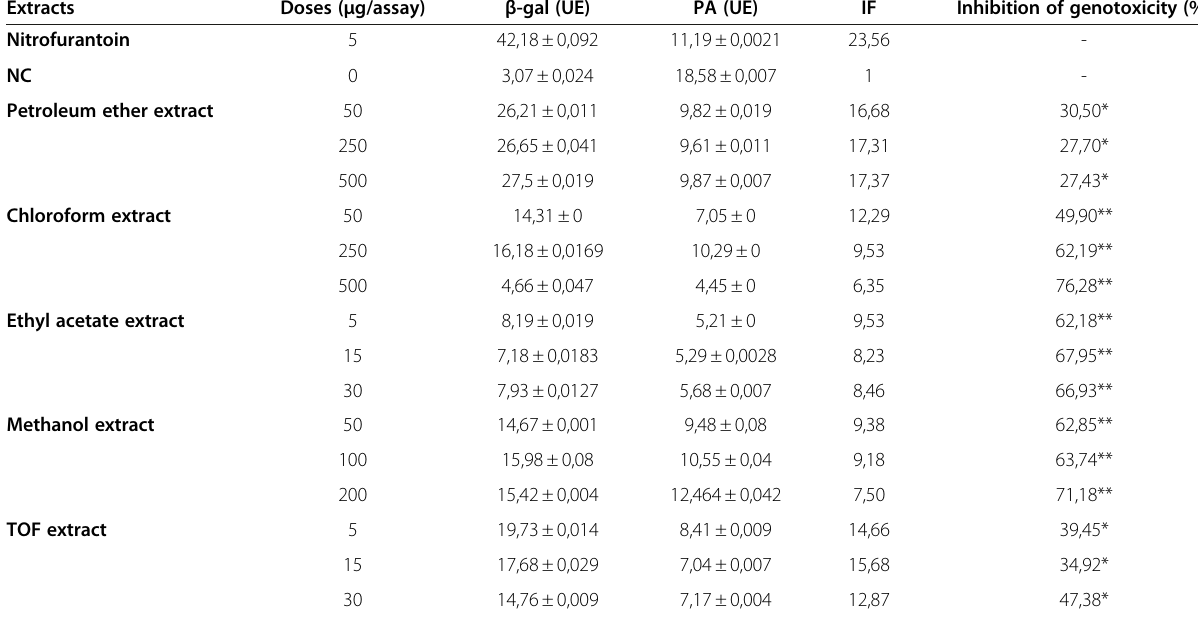
β -gal: units of β -galactosidase; AP: units of phosphatase alkaline; IF: induction factor. Positive control of genotoxicity (nitrofurantoin); NC: negative control (non-treated cells). Results were expressed as percentage of inhibition of genotoxicity compared to the positif control (Nitrofurantoin). Values represent the mean±SD of three separate experiments. The statistical significance of results was evaluated by the Student ’ s t-test. *P<0.05, **P<0.01 means significant difference between positif control and treated sample.